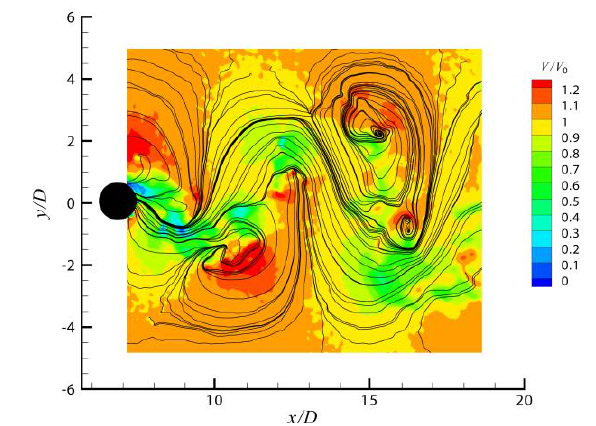
Fig.18 . Normalized velocity magnitude contour plot at fourth time step obtained for wake